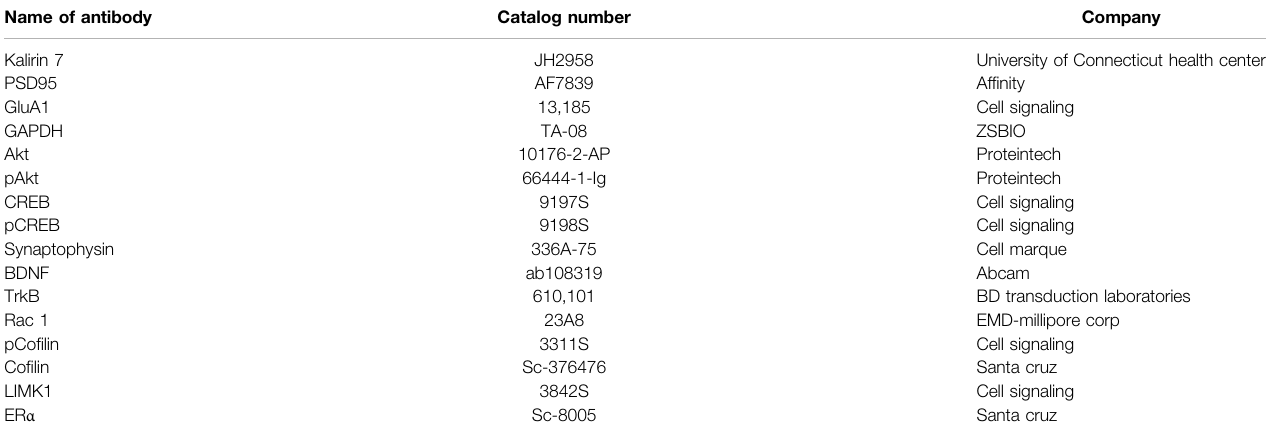
TABLE 1 | List of antibodies used in the study.